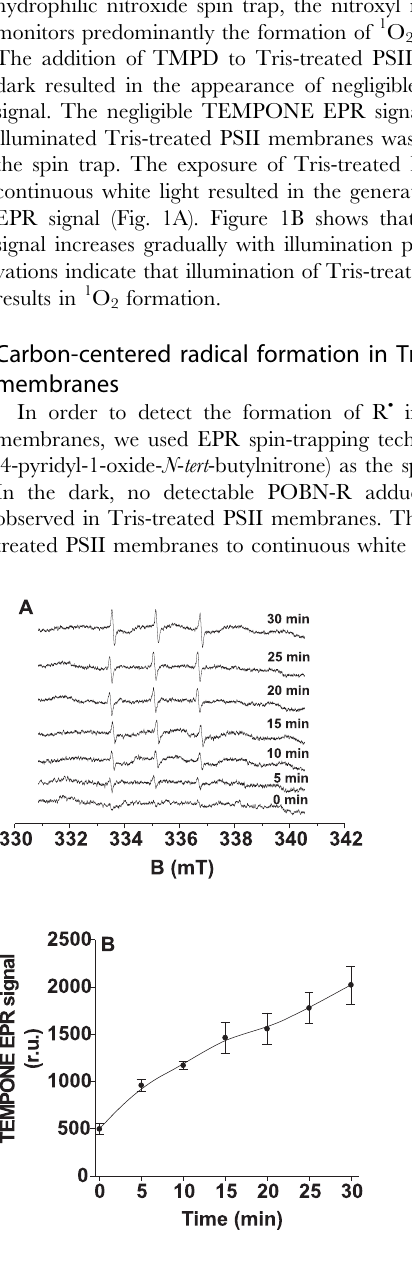
Figure 1. Light-induced TEMPONE EPR spectra measured in Tris-treated PSII membranes. [A] Tris-treated PSII membranes (200 m g Chl ml 2 1 ) were illuminated with white light (1000 m mol m 2 2 s 2 1 ) in the presence of 50 mM TMPD and 40 mM MES-NaOH (pH 6.5) for the time period as indicated in figure. [B] Time profile of TEMPONE EPR signal measured in Tris-treated PSII membranes under light illumination. The data represent the mean value ( 6 SD) of at least three experiments.